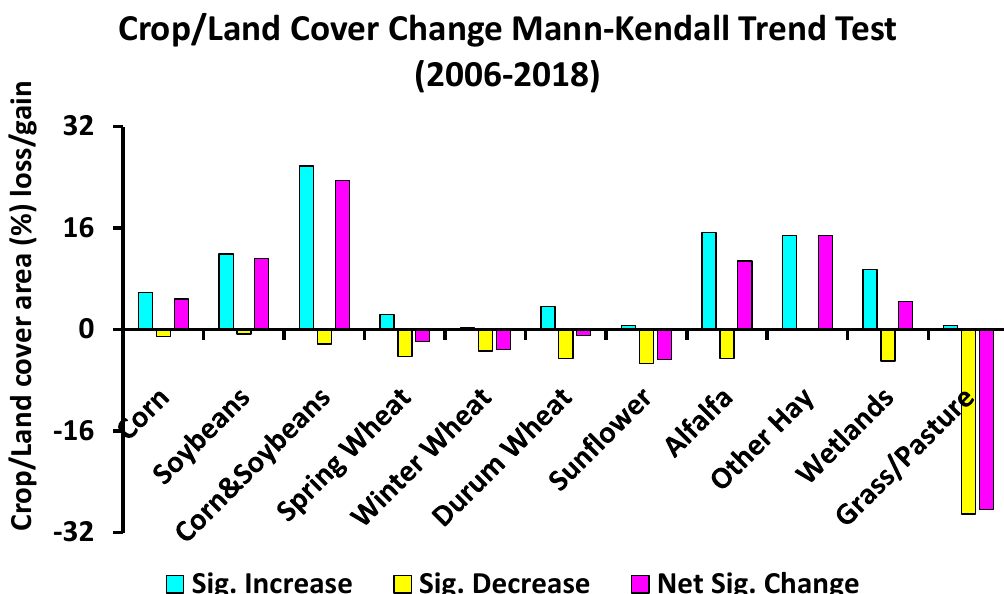
Figure 5. Significant changes in the US PPR: Mann–Kendall trend test crop / land cover area percentage (%) significant changes ( p < 0.05) using CDL data for 2006 through 2018. Significantly increased (gains in cyan), significantly decreased (losses in yellow), and net change (magenta) trends are presented for each crop / land cover. Note the grass / pasture and combined corn and soybeans exhibit opposite directions and larger magnitude net changes. Details are presented in Table S1.